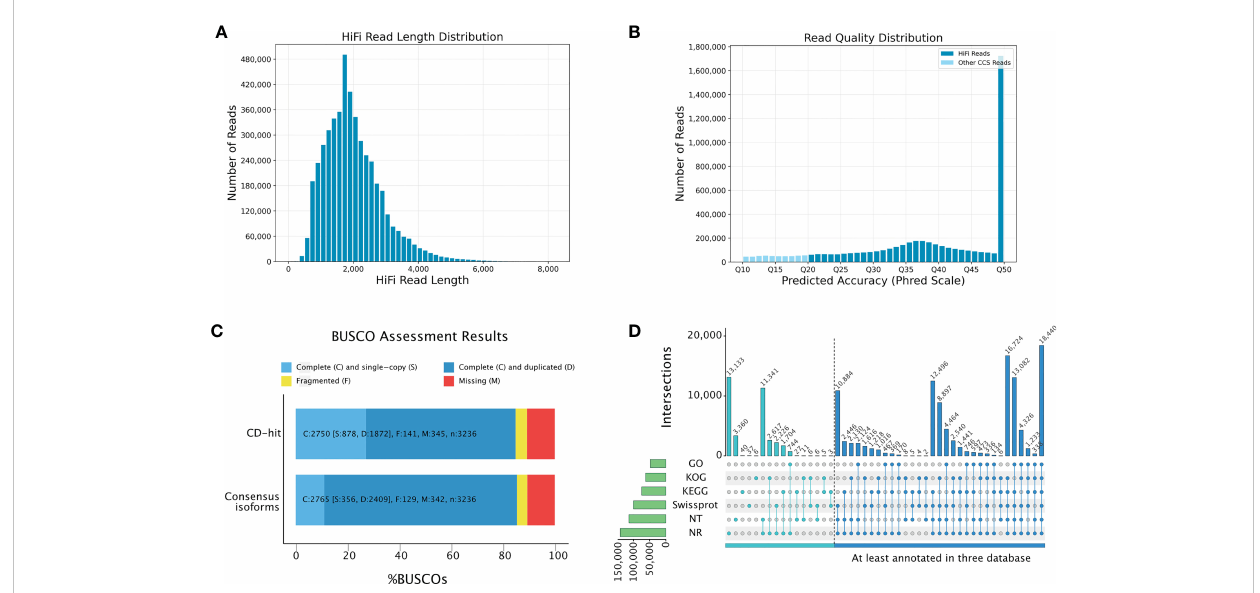
FIGURE 4 Construction of multi- fl ux full-length transcriptome of P. sibiricum . (A) Length distribution of high fi delity (HiFi) reads. (B) Quality distribution of HiFi reads. (C) BUSCO evaluation of the transcriptome completeness. CD-hit represents non-redundant transcripts. Consensus isoforms represent all detected full-length transcripts. (D) Annotation of the full-length nonredundant transcripts according to multiple